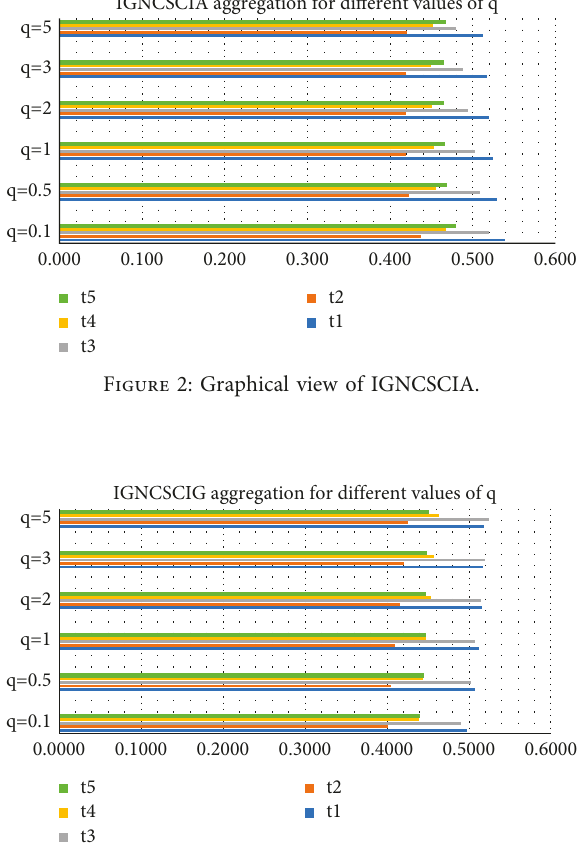
Figure 3: Graphical view of IGNCSCIG.